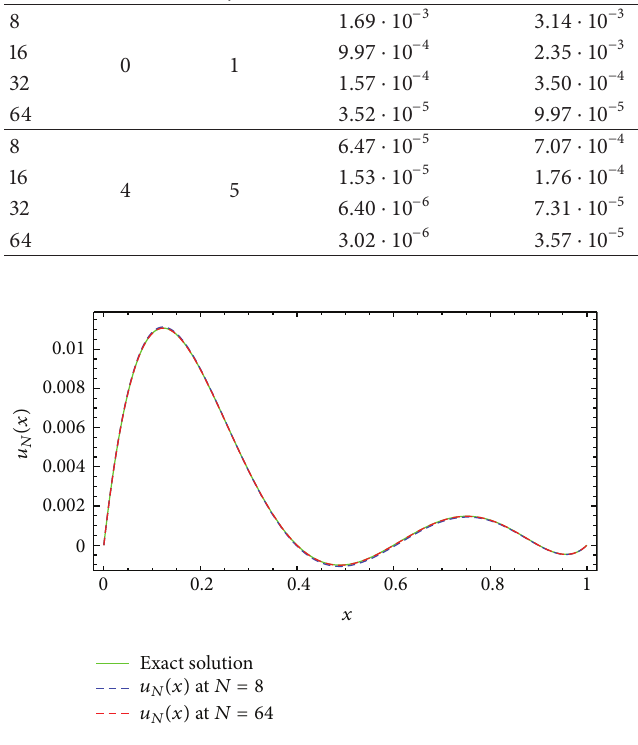
Figure 9: Comparing the exact and approximate solutions by using MGLT (Radau) at 𝑁 = 8, 64 , with 𝛼 = 2 and 𝛽 = 4 .